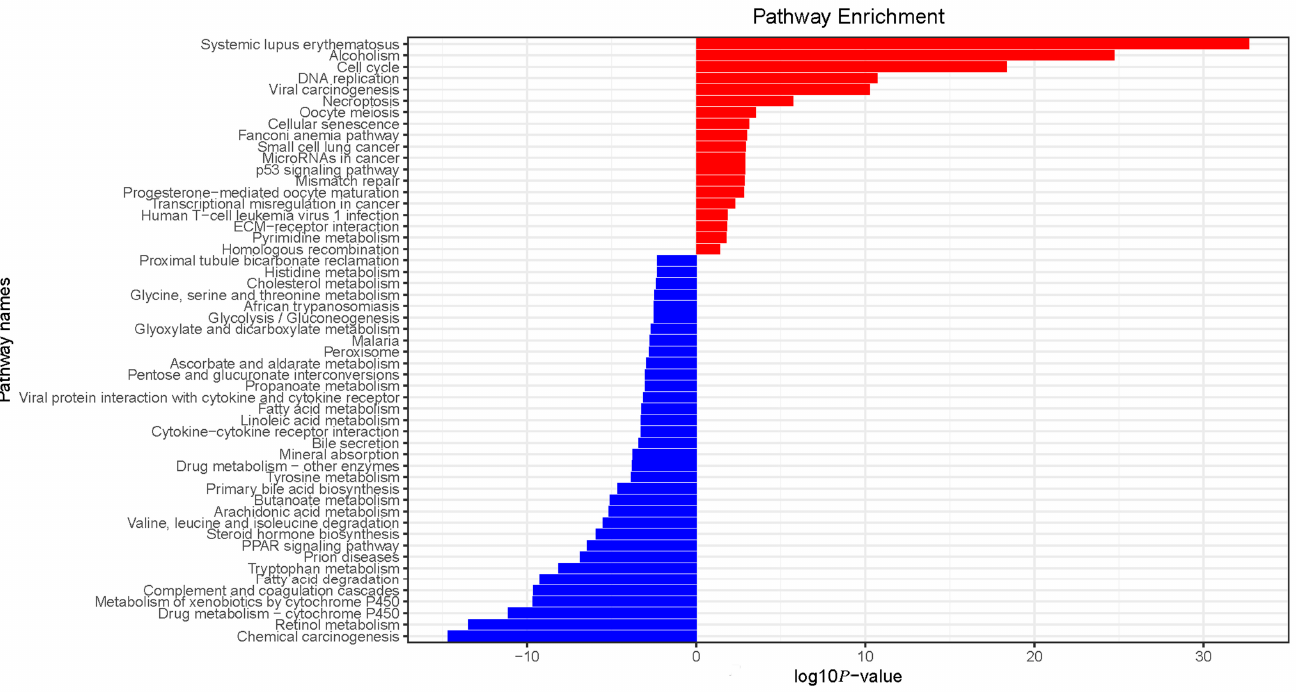
Figure 5. Top pathways associated with upregulated and downregulated pathways of mRNAs.